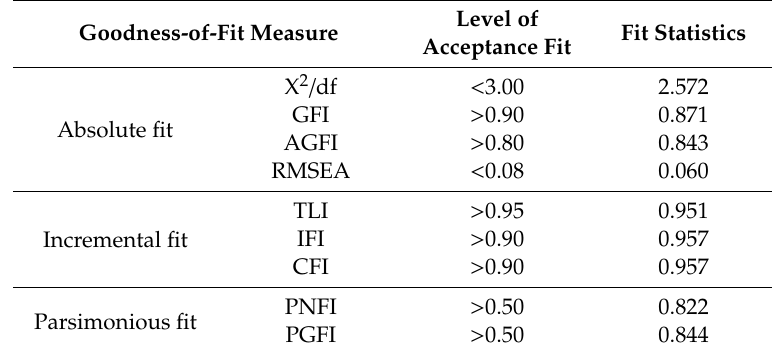
Table 11. Goodness-of-fit of the initial structural model (M1).